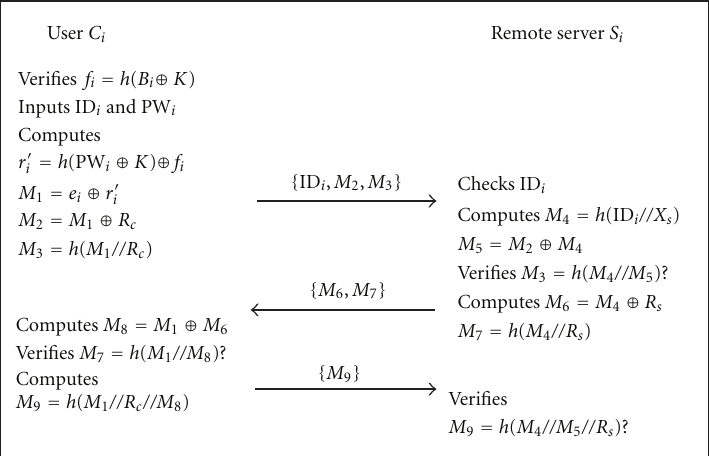
Figure 3: Login phase and authentication phase of the enhanced